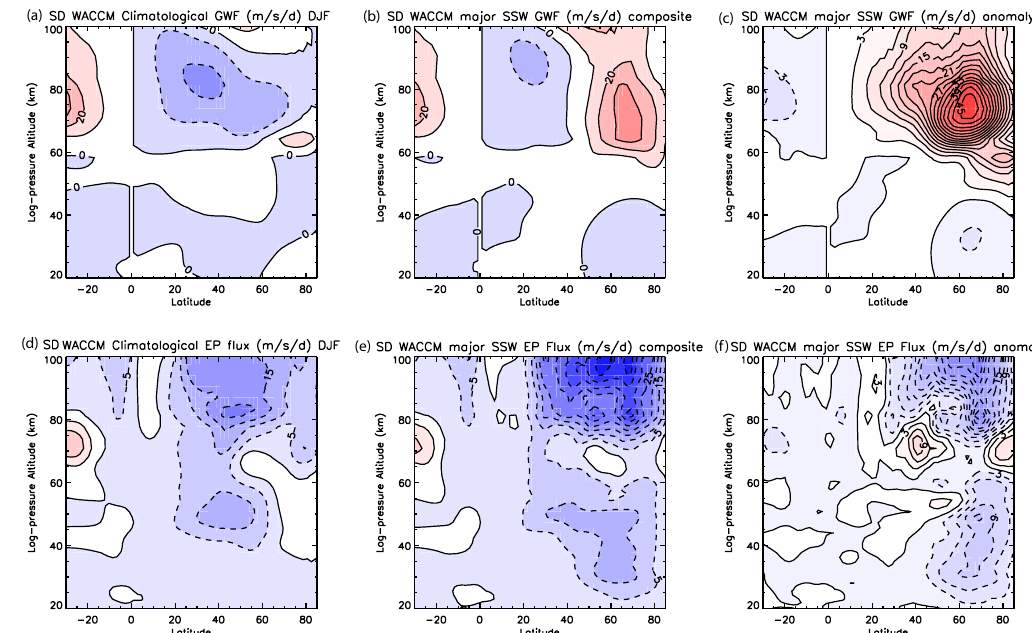
Figure 2. The climatological average zonal-mean gravity wave forcing (top) and Eliassen–Palm flux (bottom panels), respectively, (a, d) between December and February from 1988 to 2010, (b, e) during seven days centered around 10 major SSW events between 1988 and 2010 and (c, f) Gravity wave forcing anomaly calculated as difference during the composite SSW event from the climatological